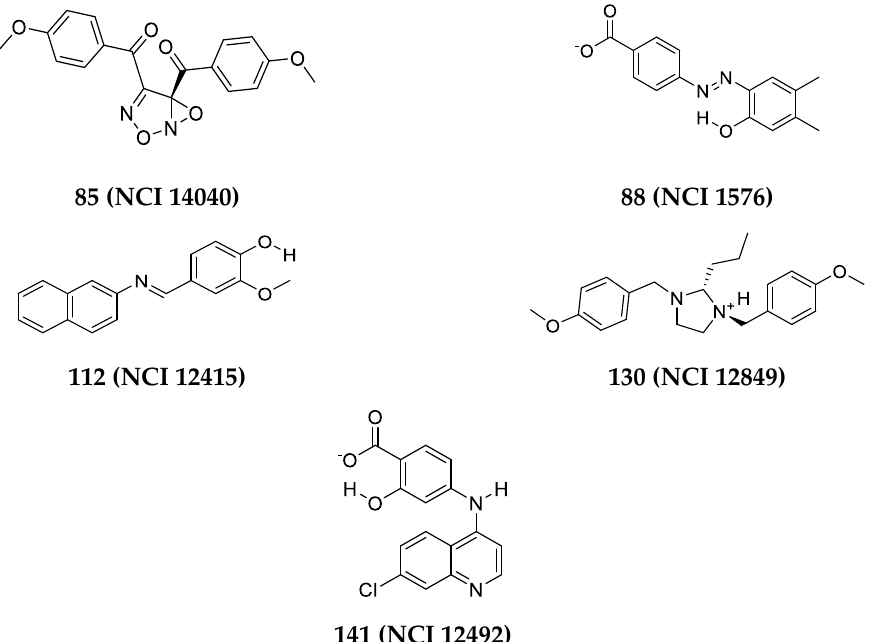
Figure 4. Dose-response curves for the three potent hits as anti-Aurora-A kinase using Z (cid:48) -LYTE ® Figure 4. Chemical structures of the five hits that demonstrated inhibitory activity against Aurora-A kinase assay (Invitrogen, Carlsbad, CA, USA) showing their IC 50 values in Table 4. kinase using Z′ -LYTE ® assay (Invitrogen, Carlsbad, CA, USA) kinase inhibition assay with IC 50 values summarized in Table 5. The identities and purities were validated by NMR and mass spectroscopy in Three of these promising hits (inhibition % at 10 µ M above 56%) were next tested at several (Figures S3 – S38 in Supplementary Data). concentrations range (0.1–100 µ M) to determine their IC 50 values by using nonlinear regression to plot log (concentration) vs. inhibition % curves (shown in Figure 5) using GraphPad Prism